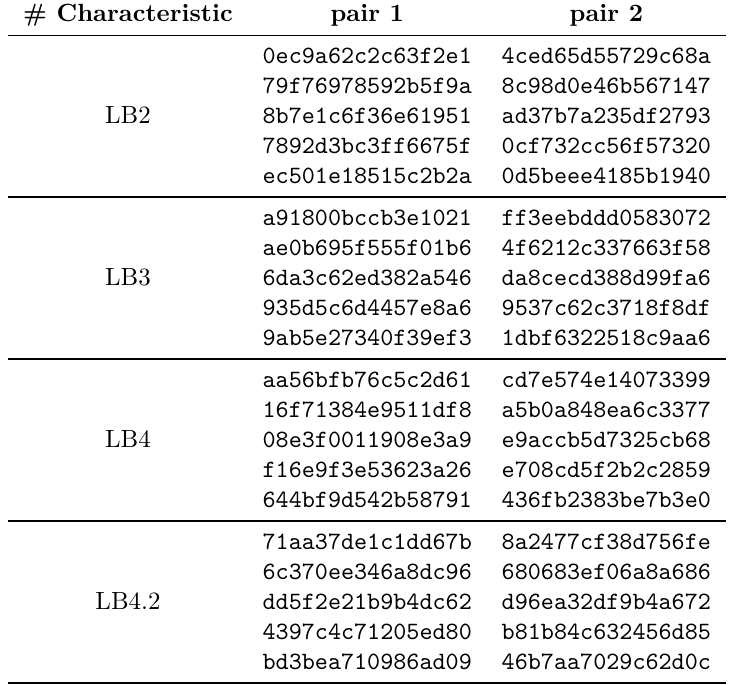
Table 19: Conforming pairs for limited-birthday distinguishers.